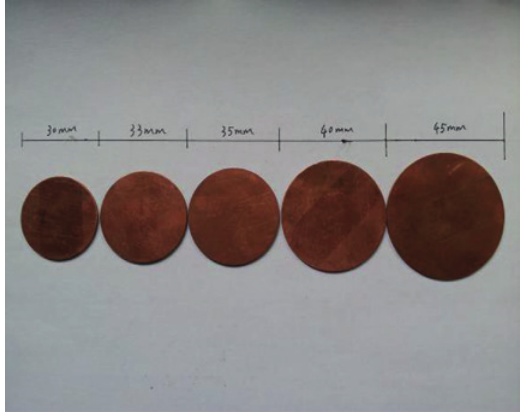
Fig. 3: T2 copper waveform